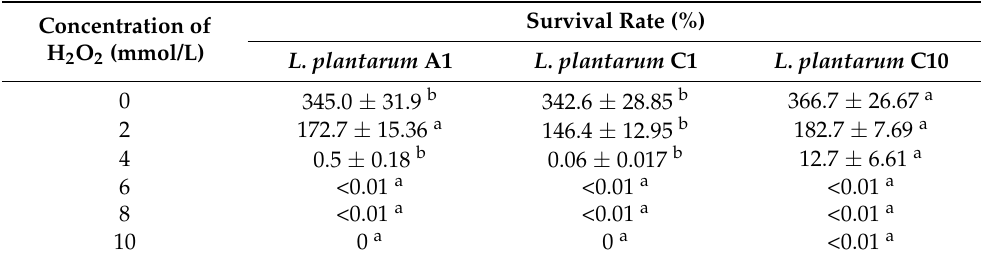
Table 8. Survival rates (%) of Lactiplantibacillus plantarum A1, C1 and C10 in different